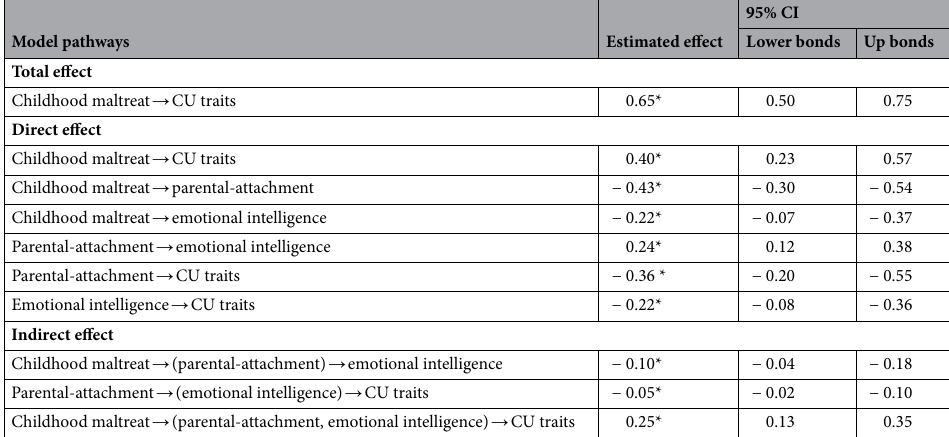
Table 3. Direct and indirect effects and 95% confidence intervals for the Model B (n = 429). *Empirical 95% confidence interval does not overlap with